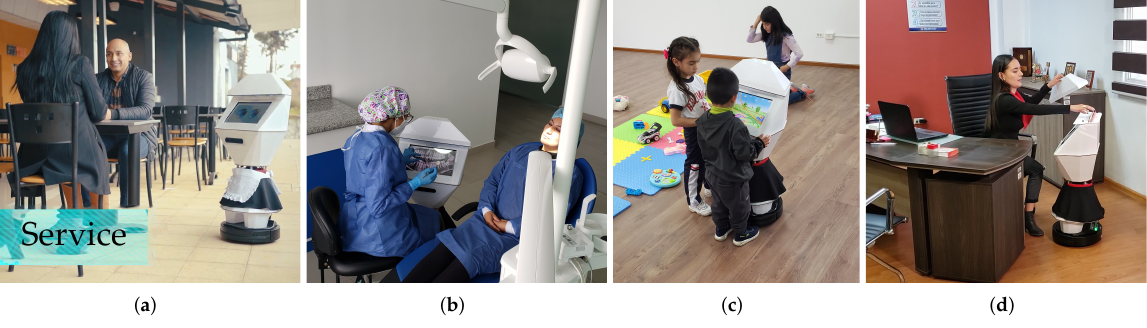
Figure 12. Testing the use of the robot in real environments: ( a ) Restaurant. ( b ) Dental office. ( c ) Kindergarten. ( d )